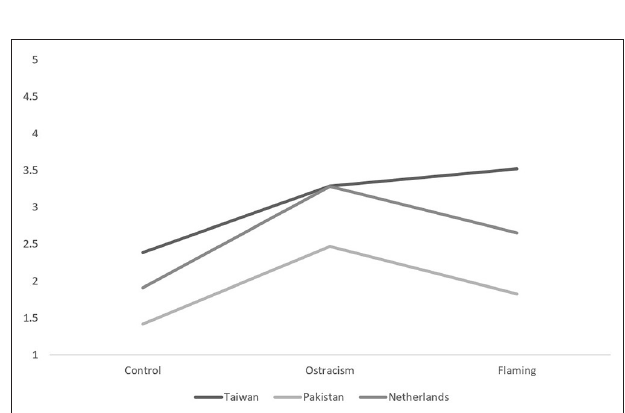
FIGURE 2 | The between-subjects interaction between nationality and trolling type for